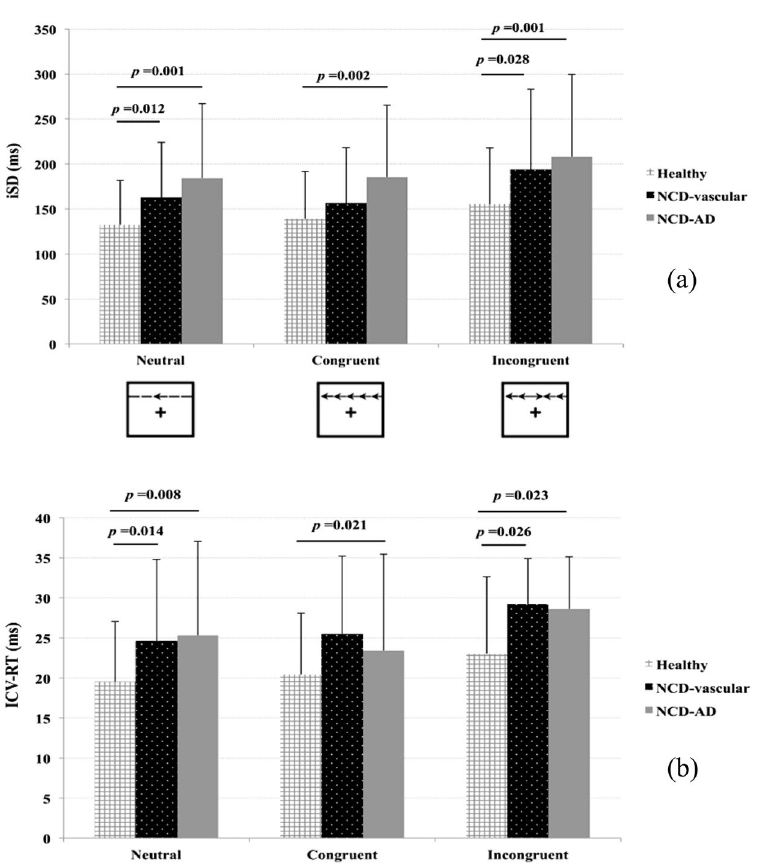
Figure 1. Intra-individual variability of RT between healthy and NCD subgroups. Elevation in iSD ( a ) and ICV-RT ( b ) has been found in NCD-AD and NCD-vascular